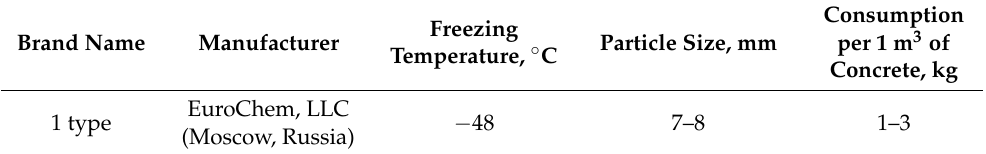
Table 9. Characteristics of CaCl 2